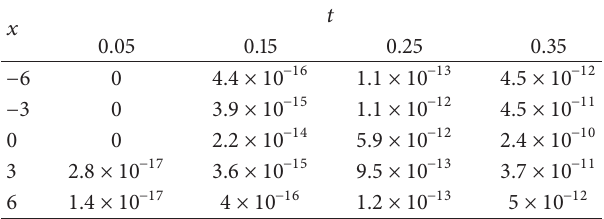
(𝑥,𝑡)| for Fisher equation, with app